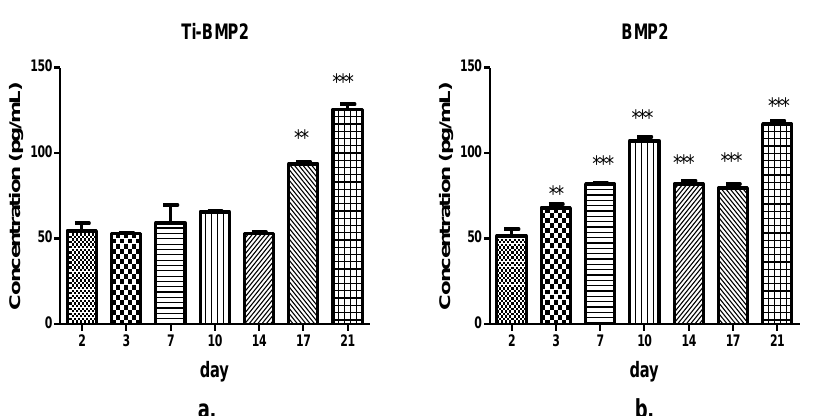
Figure 6. The concentration levels of bone morphogenetic protein 2 at different time intervals (days 2–21): ( a ) in the presence of titanium implants (Ti-BMP2) and ( b ) in the absence of titanium implants (BMP2) in the culture media. **— p < 0.001, ***— p < 0.0001 where p < 0.05 is considered the level of statistical significance.